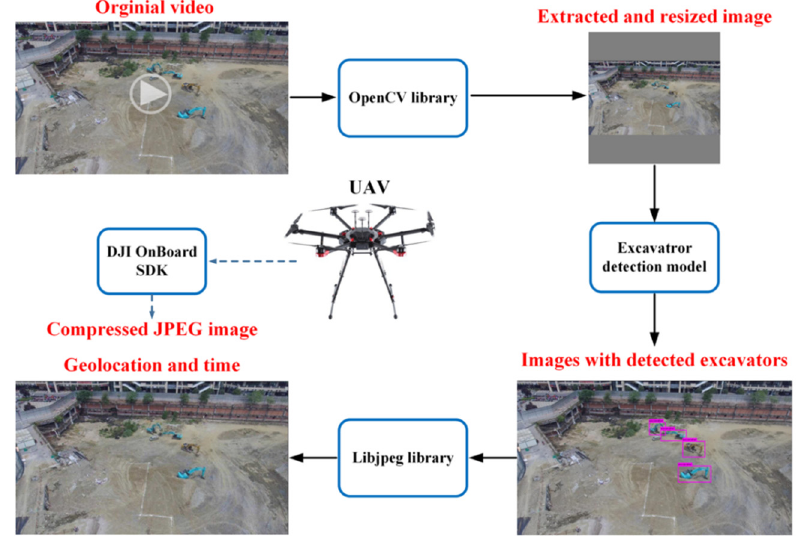
Figure 6. Data-processing flow in the UAV Module. Images are extracted from the original video and resized by the OpenCV library. Then, each image is orderly imported into the excavator detection model to identify if there are any excavators in the image. Images containing excavators are compressed via the Libjpeg library and transmitted to the Warning Module along with the recorded geolocation and acquisition time.